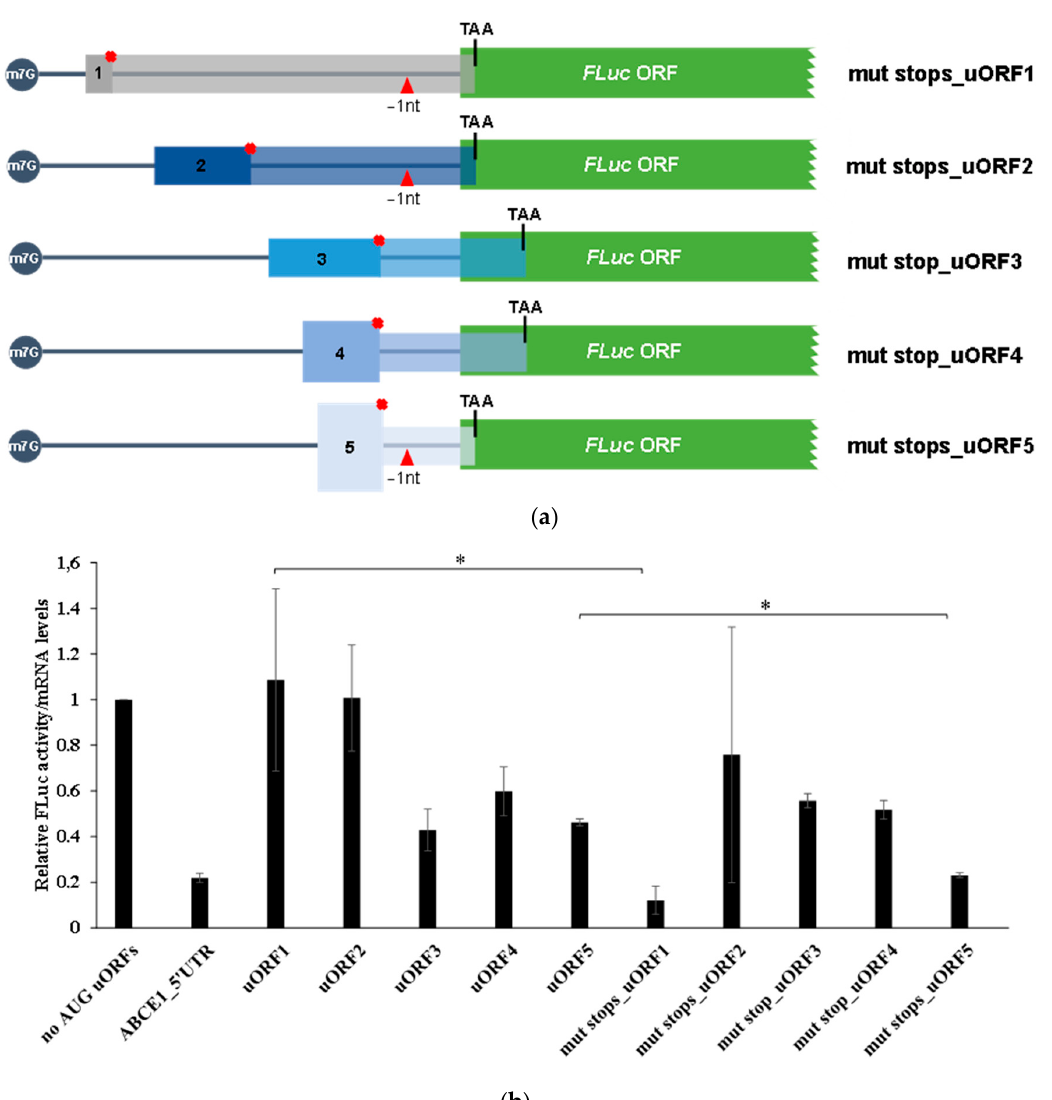
Figure 6. uORF 2, uRF3, and uORF4 present in the ABCE1 5 ′ -leader sequence have the potential to be frequently bypassed by the ribosomes. ( a ) Schematic representation of the constructs obtained by series of sequential mutagenesis to obtain out-of-frame and overlapped uORFs with the main coding sequence. In the uORF1, uORF2 and uORF5 constructs, 1 nucleotide (T) was deleted in the intercistronic space and, for all the five AUG uORF-individual constructs (uORF1-5), each in-frame stop codon was mutated (TGA → GGA), resulting in the constructs “mut stops_uORF1”, “mut stops_uORF2”, “mut stop_uORF3”, “mut stop_uORF4”, and “mut stops_uORF5”. The red cross represents the point mutations at the uORF’s stop codons, and the red triangle indicates the 1-nucleotide deletion. The five non-AUG uORFs are present in these constructs but not represented in the figure to simplify the scheme. ( b ) HCT116 cells were transiently co-transfected with each one of the constructs described in ( a ), or ABCE1_5 ′ UTR, “no AUG uORFs”, or the constructs with only one functional AUG uORF (uORF1-5) already described in Figure 2a, and the pRL-TK plasmid. Expression of these constructs was analyzed as described in Figure 2b legend. The results are presented as mean ± SEM from at least three independent experiments. Student’s t-test was applied for statistical significance: p < 0.05 (*).